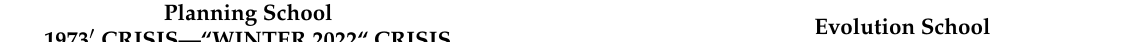
Table 9. The main features of two views on energy security strategies: the planning and